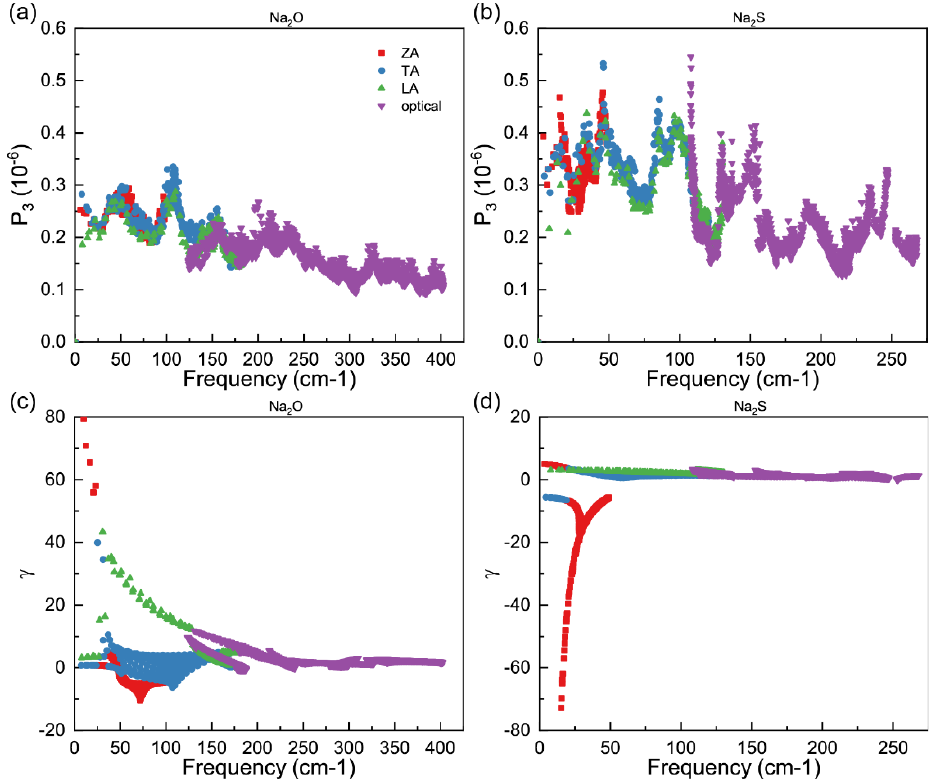
Figure 5. The ( a , b ) phase space for anharmonic scattering and ( c , d ) Grüuneisen parameter for different modes for Na 2 O and Na 2 S monolayers at room temperature.